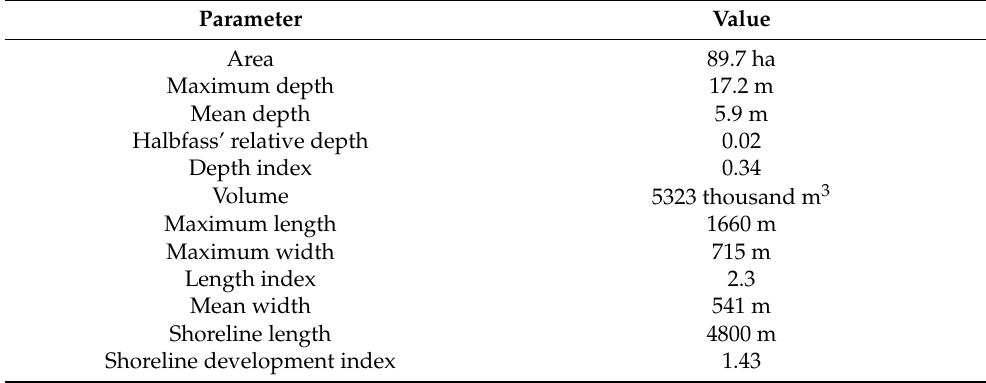
Table 1. Morphometric characteristics of Lake Kortowskie (data from the Department of Water Protection Engineering and Environmental